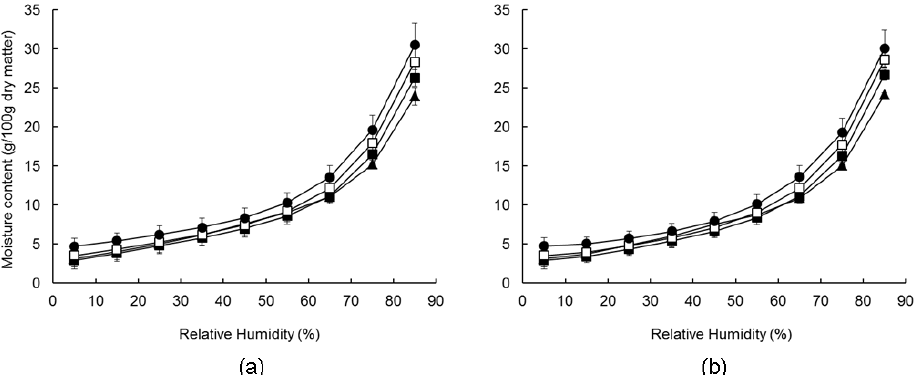
Figure 1. Sorption isotherms for unsalted fermented milk–wheat composites (FMWC) during desorption ( a ) and adsorption ( b ). The ratio of fermented milk-to-wheat was 1.5( (cid:78) ), 2.3 ( (cid:4) ), 3.0 ( (cid:3) ), or 4.0 ( ). Presented values are the means of two replicate trials; error bars represent standard deviations of the mean.